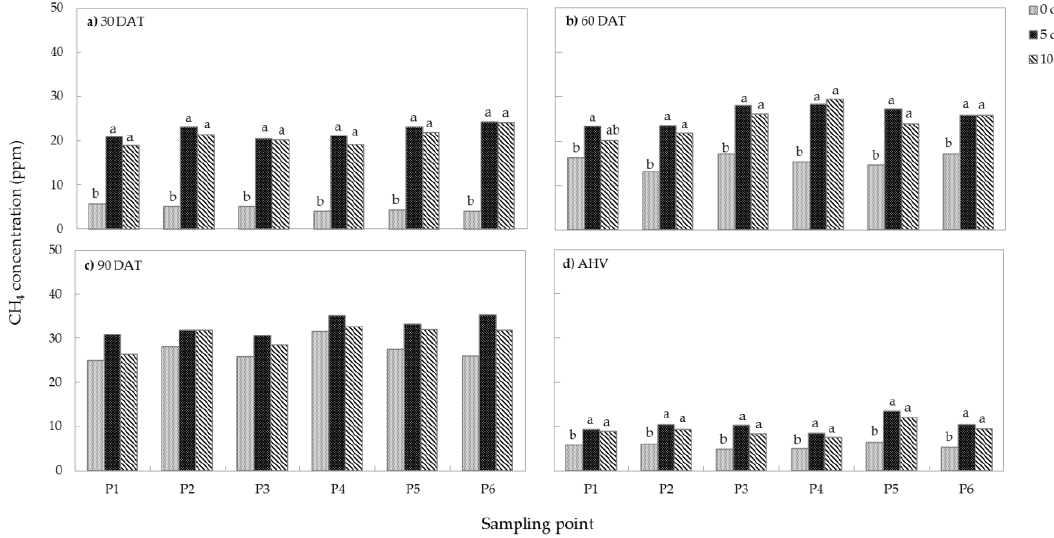
Figure 4. The average of CH 4 concentrations at 0, 5 and 10 cm depths from 6 sampling points in each growing stage by using soil gas sampling tubes. Different letters indicate significant differences between soil depths at the same place (LSD test, p < 0.05). No significant differences were found between measurement depths at 90 DAT.